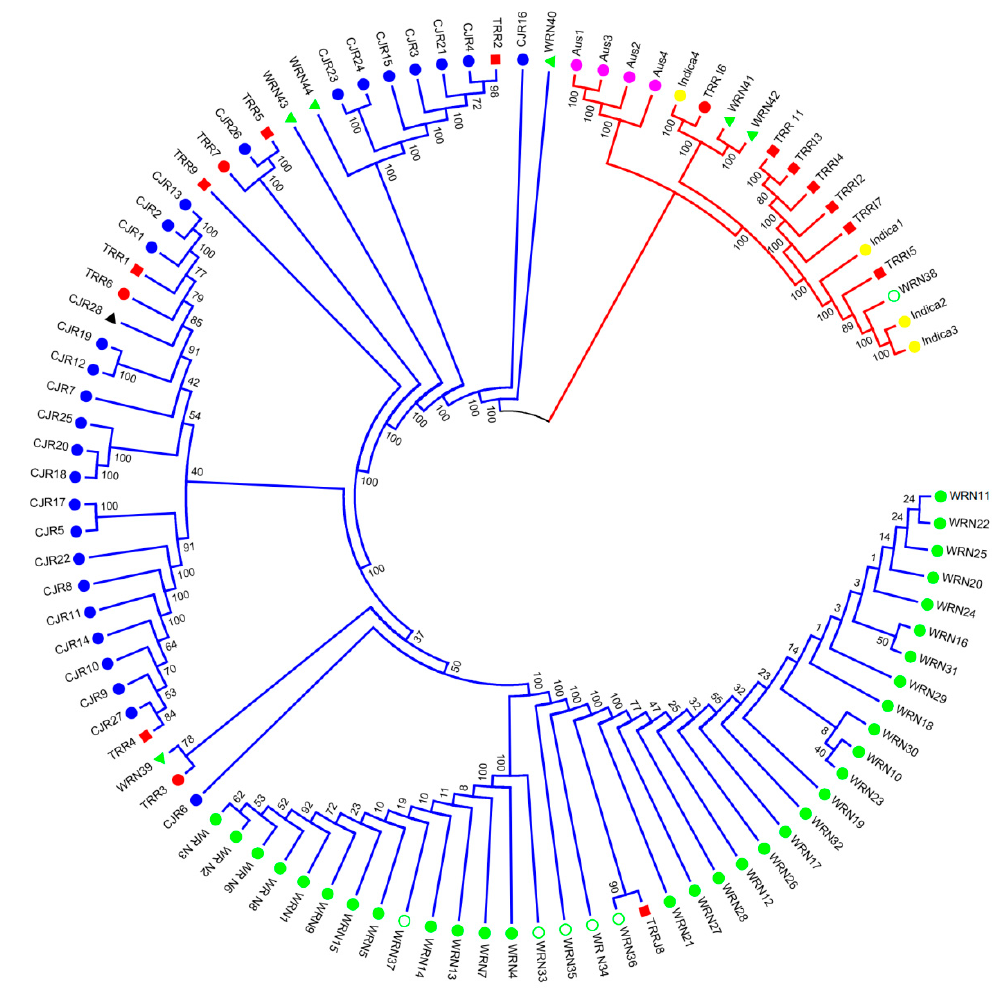
Figure 1. Neighbor-joining tree built from 50K SNPs (single nucleotide polymorphisms). Numbers at the branch nodes represent bootstrap values. Blue- and red-colored branches indicate the japonica and indica groups, respectively. Solid and open green circles indicate WRN (weedy rice accessions sampled from Nagano, Japan) samples of the modern and early races, respectively. Non-Nagano weedy rice accessions are indicated by green triangles. Blue circles indicate CJR (cultivated japonica rice). Red circles and red squares indicate Japanese TRR (traditional red rice) and Chinese TRR, respectively. Indica and aus are indicated by yellow and pink circles, respectively. The black triangle indicates the japonica rice Koshihikari.